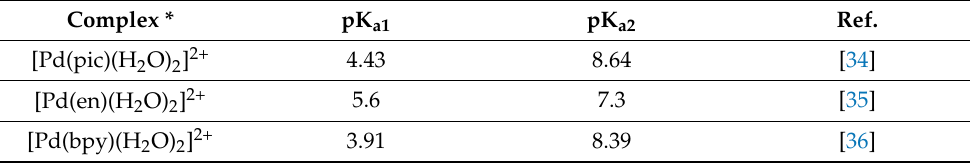
Table 1. Comparison of acid dissociation constants of some Pd(II) diaqua